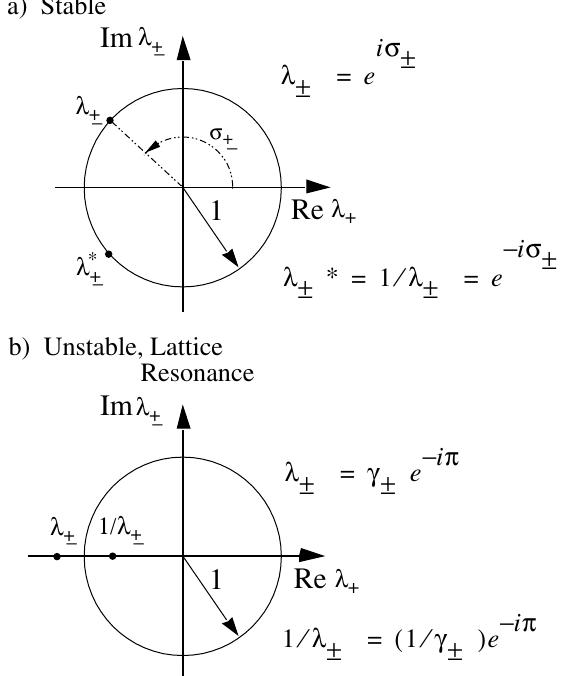
FIG. 5. Two possible classes of eigenvalue symmetries for continuous focusing or periodic solenoidal focusing channels with round beam equilibrium corresponding to stability in (a), and instability in